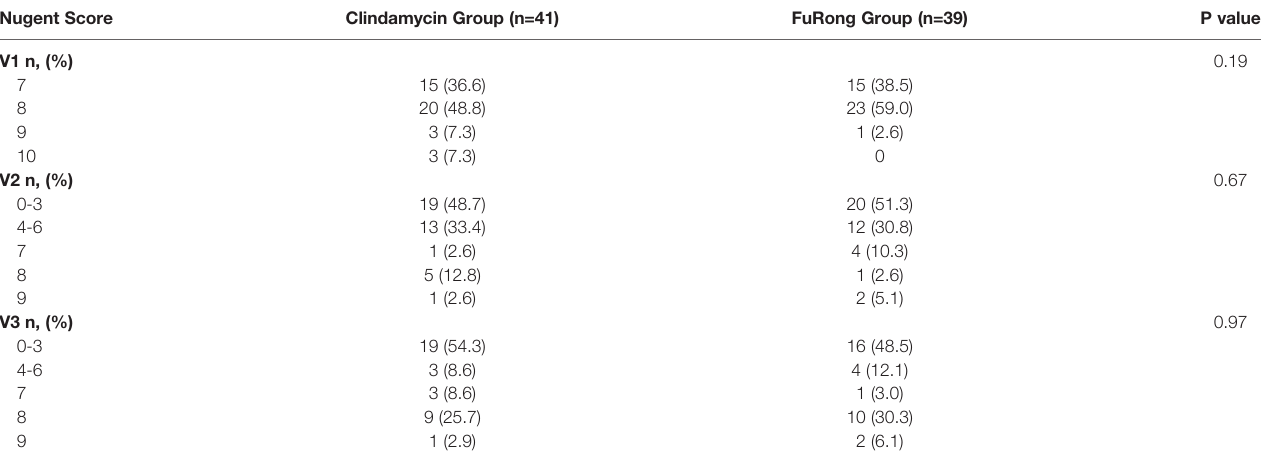
TABLE 3 | Nugent score during the three follow-up periods.